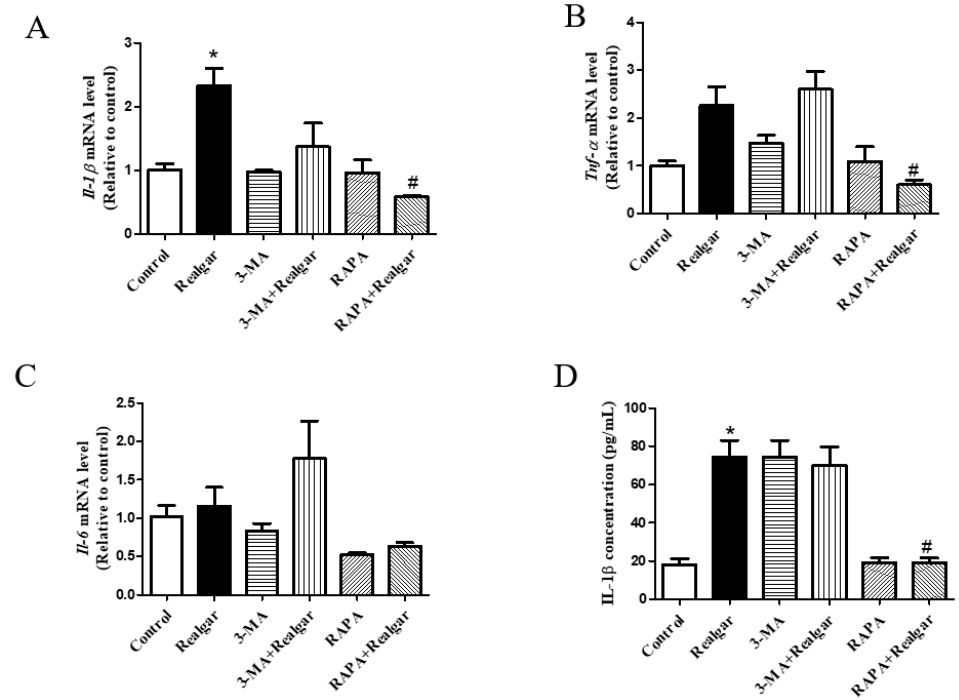
Figure 2. The effect of autophagy on realgar-induced liver injury. The liver index ( A ). The ALT ( B ) and AST ( C ), ALP ( D ), γ -GGT ( E ), TBIL ( F ), ALB ( G ), UN ( H ), Cr ( I ) and LDH ( J ) levels in mouse plasma ( n = 6). Data are presented as mean ± SEM. * p < 0.05, compared with control group; # p < 0.05, compared with realgar-treated group. ( K ) Representative images of morphological changes in mouse liver examined by H&E staining (200 × , 400 × ). The scale is 100 µ m and 50 µ m. The arrows refer to cytoplasm vacuolization, focal nuclear pyknosis or inflammatory infiltration.